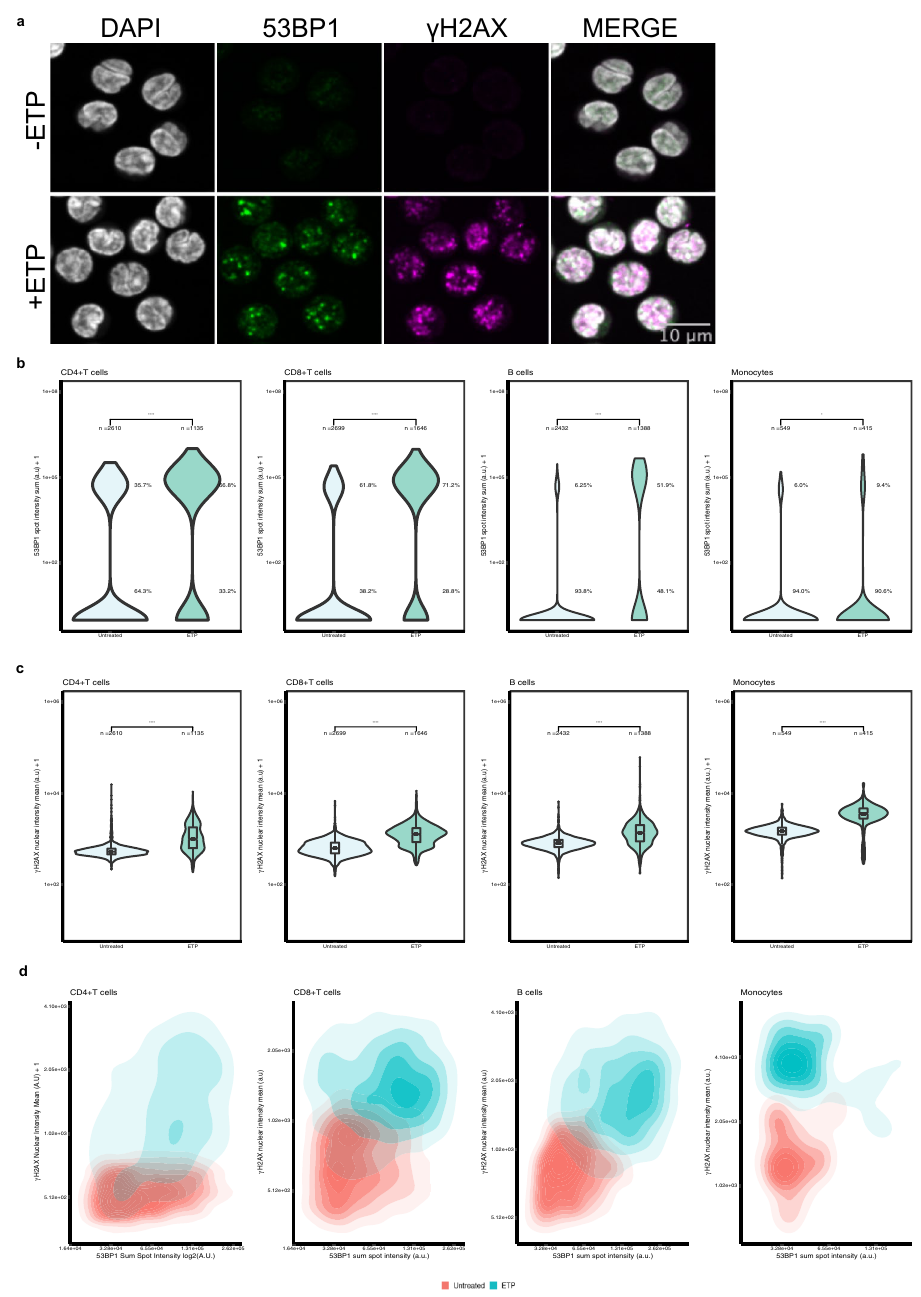
Figure 3. Detection of DNA damage in CD4 + T, CD8 + T, B cells and monocytes using HTI. ( a ) CD4 + T cells were either left untreated or treated with 30 µM ETP for 1.5 h before being subjected to HTI. DNA damage sites are indicated by formation of 53BP1 and γ-H2AX foci detected by specific antibodies. Scale bar: 10 µm. ( b ) Distribution of 53BP1 sum spot intensity in DMSO- or ETP-treated cells. ****: p < 0.0001. ( c ) Distribution of γ-H2AX mean nuclear intensity in DMSO- or ETP-treated immune cells. ****: p < 0.0001 using Mann– Whitney-Wilcoxon test. Number of analyzed cells (n) indicated for each sample. The values are representative of at least 3 experiments. Boxes represent the first and third quartiles of the distribution. The line represents the median. The whiskers represent the highest and lowest data points within 1.5 times the interquartile range above the upper quartile and below the lower quartile. ( d ) Two-dimensional kernel density contour plots of the correlation between 53BP1 sum spot intensity and γ-H2AX mean nuclear intensity for both ETP-treated (blue) and untreated (red) immune cell lines for the dataset shown in panels B and C. N = 3 wells per sample with at least 185 cells per